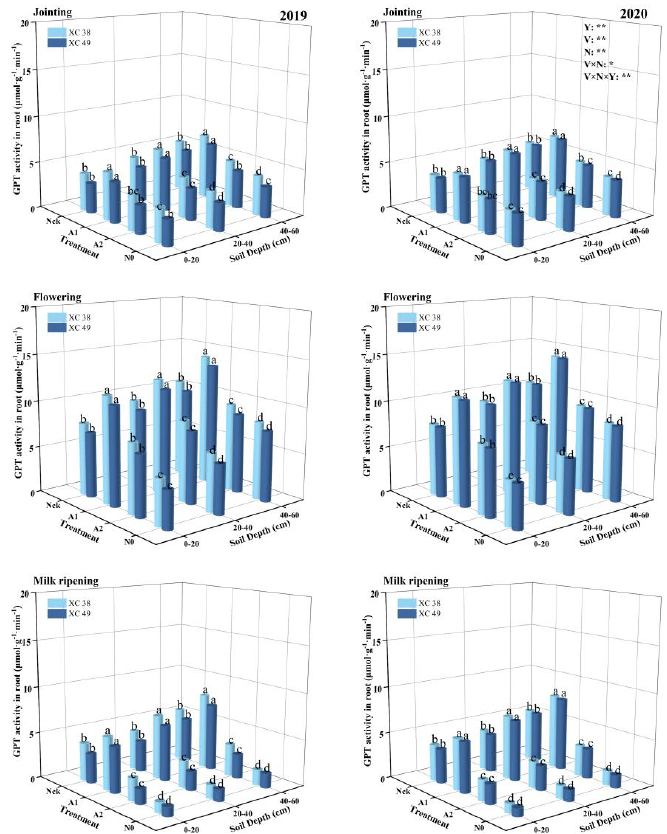
Figure 5. Effect of nitrogen supply on root GPT activity of drip-irrigated spring wheat. Note: XC 38: Xinchun 38; XC 49: Xinchun 49. Nck: 300 kg · ha − 1 ; N0: 0 kg · ha − 1 ; A1: 240 kg · ha − 1 ; A2: 210 kg · ha − 1 . V: variety, N: different nitrogen treatments, and Y: year. “*” and “**” indicate significant differences at 0.05 and 0.01 levels, ns indicates insignificant differences. Different lowercase letters indicate significant differences between treatments at the 0.05 level. Table 3. Effect of different nitrogen application rates on root antioxidant enzymes activity and MDA content of drip-irrigated spring wheat in